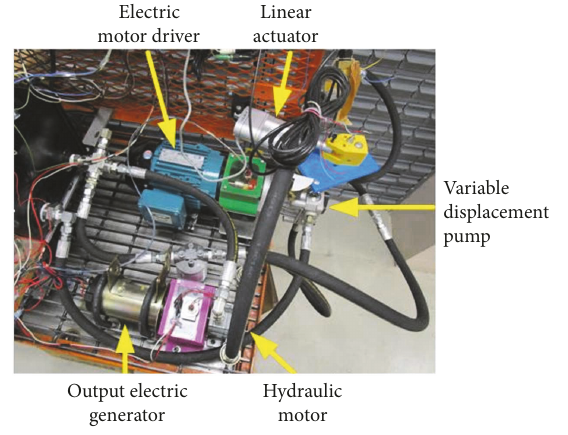
Figure 3: Test bench hardware